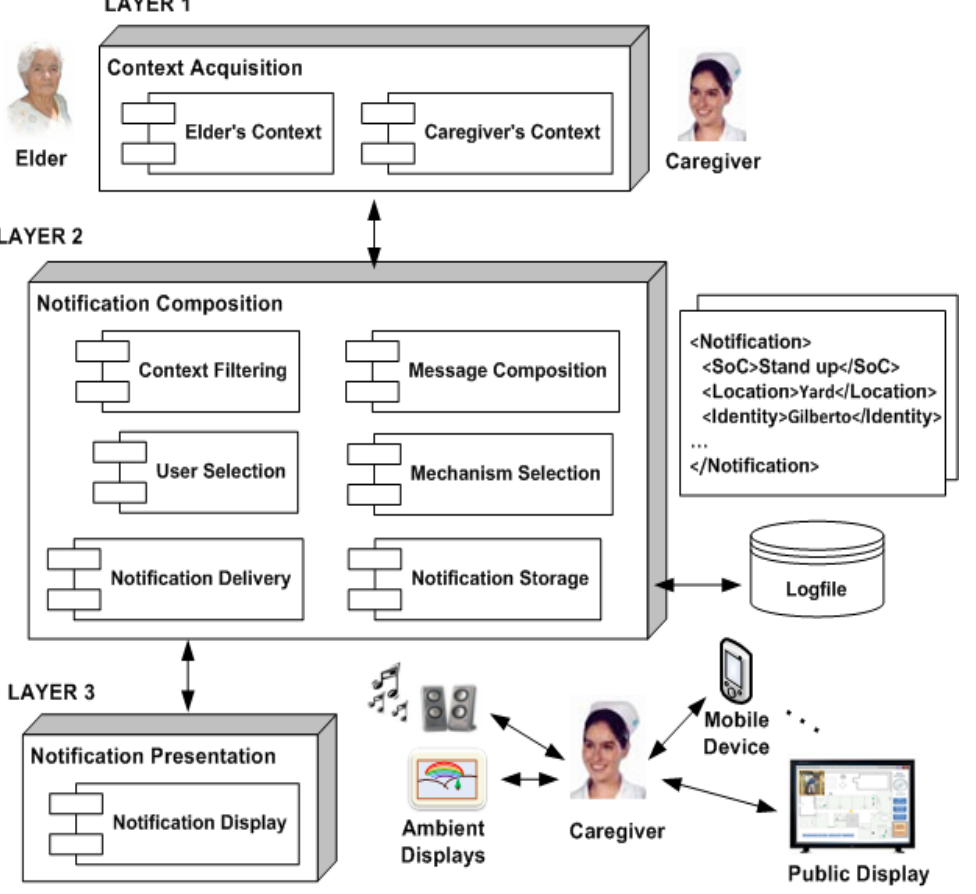
Figure 10. Architecture of the proposed CANoE-Aw